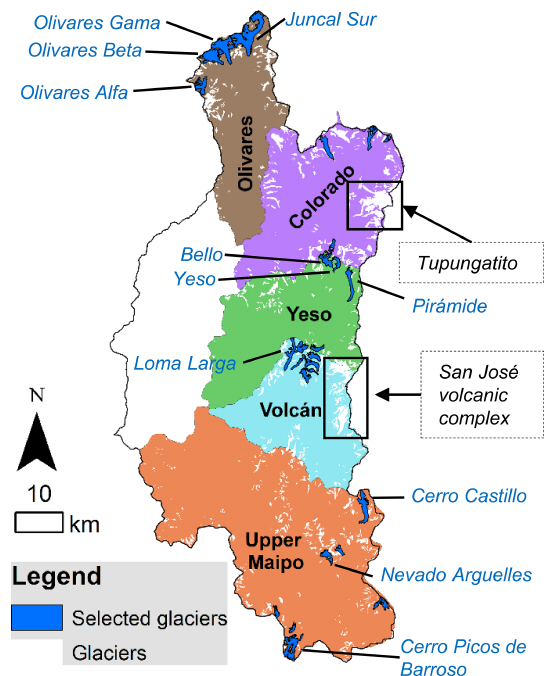
Figure 3. Location of the 26 glaciers modeled with TOPKAPI- ETH. We highlight the volcanic areas in which some large glaciers were discarded from the modeled sample. We include the name of the main glaciers in this